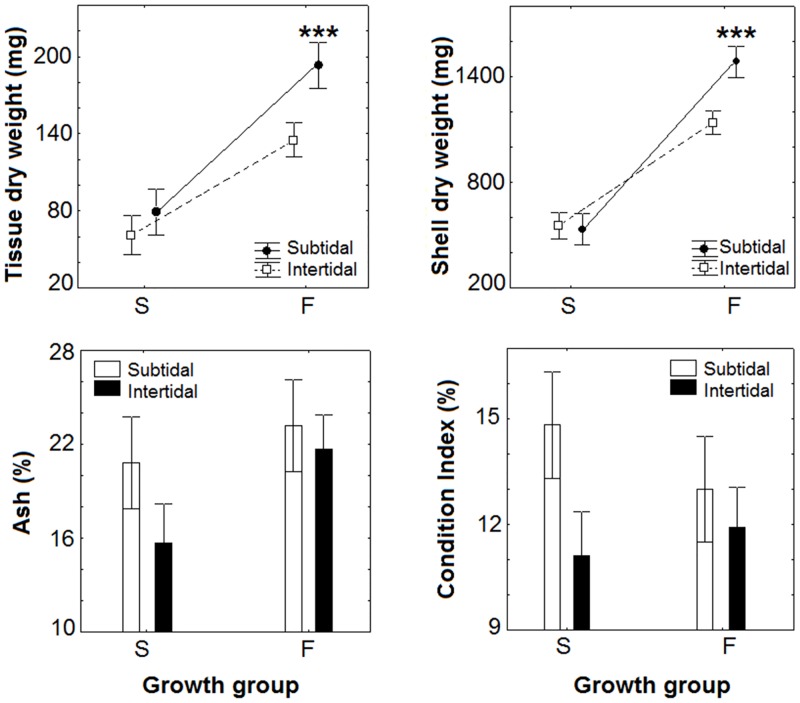
Biometric characteristics of slow (S) and fast (F) growing mussel seed originated from the subtidal and intertidal ecosystems after maintenance under standard laboratory conditions during five months.The graphs represent the mean ± SD of the tissue and shell dry weight, the percentage of ash and the condition index. Statistical differences are indicated as *** for p<0.001 (two-way ANOVA).